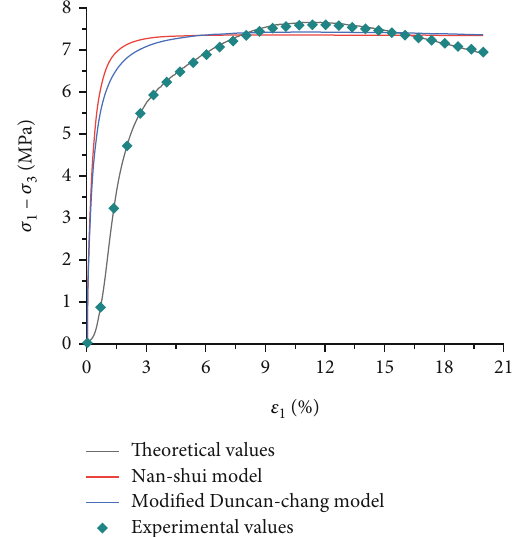
Figure 12: Comparison of theoretical model, Nan-Shui model, and Duncan-Chang model (FPC-1 under 0.2MPa con fi ning